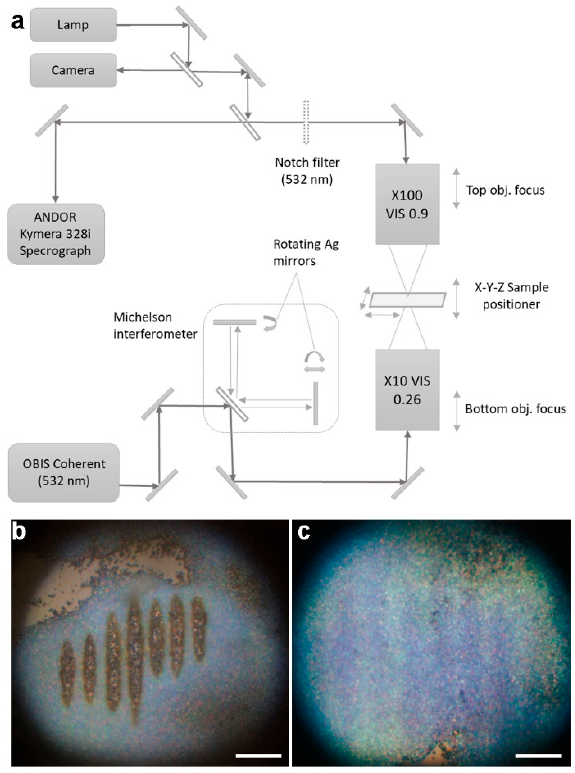
Figure 2. ( a ) Experimental setup based on the Michelson interferometer. ( b , c ) Optical images of irreversible and reversible laser patterning. Scale bar, 20 µm.